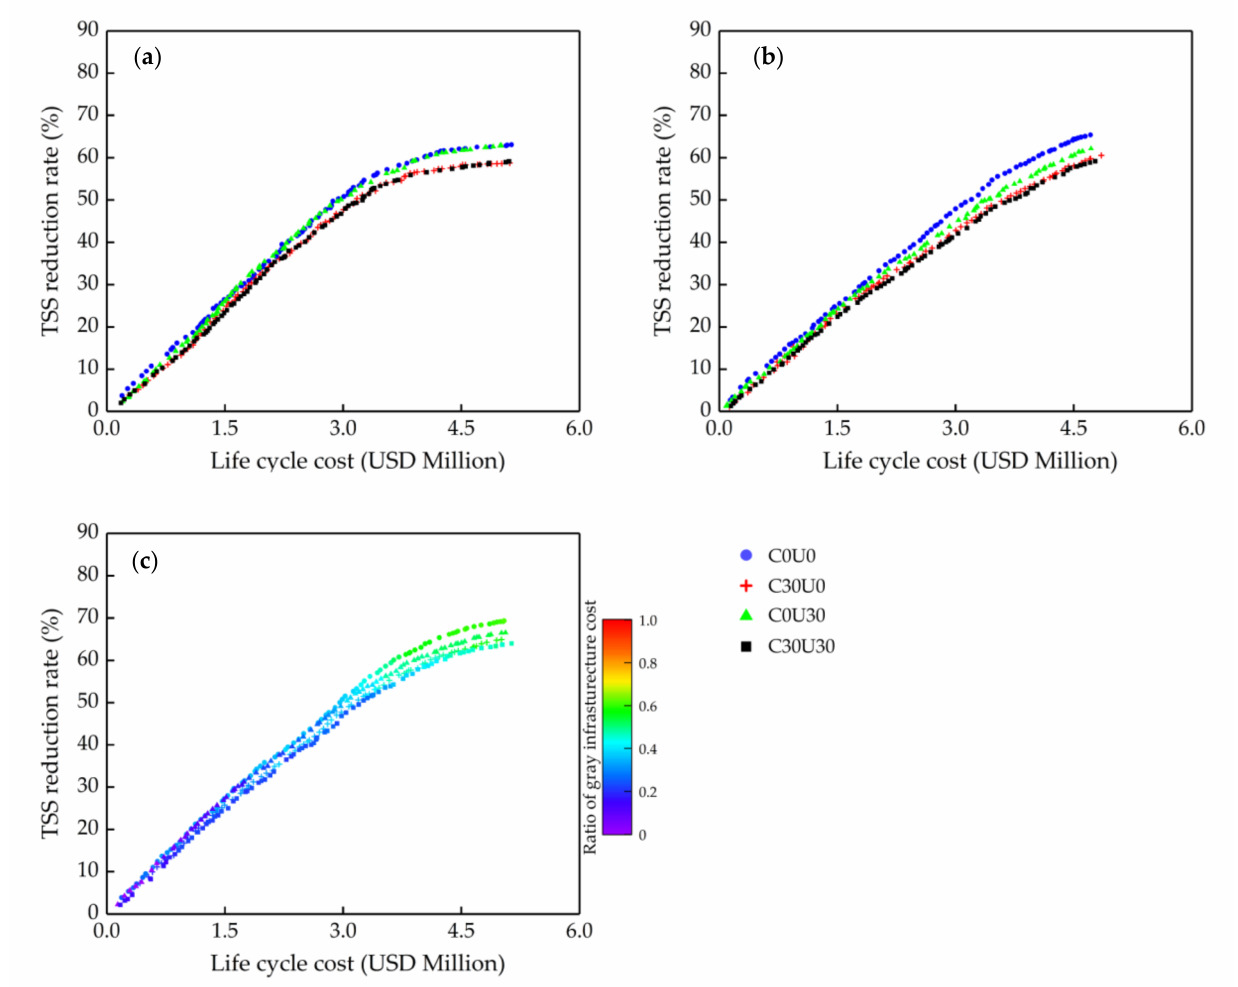
Figure 9. Pareto solution set curves under four future scenarios: ( a ) Optimizing green infrastructure only; ( b ) Optimizing gray infrastructure only; ( c ) Optimizing green-gray